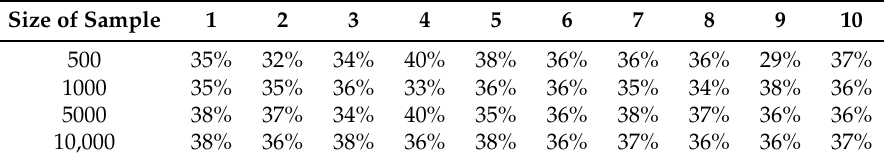
Table 7. Probabilities in ten scenarios (Gaussian mixture